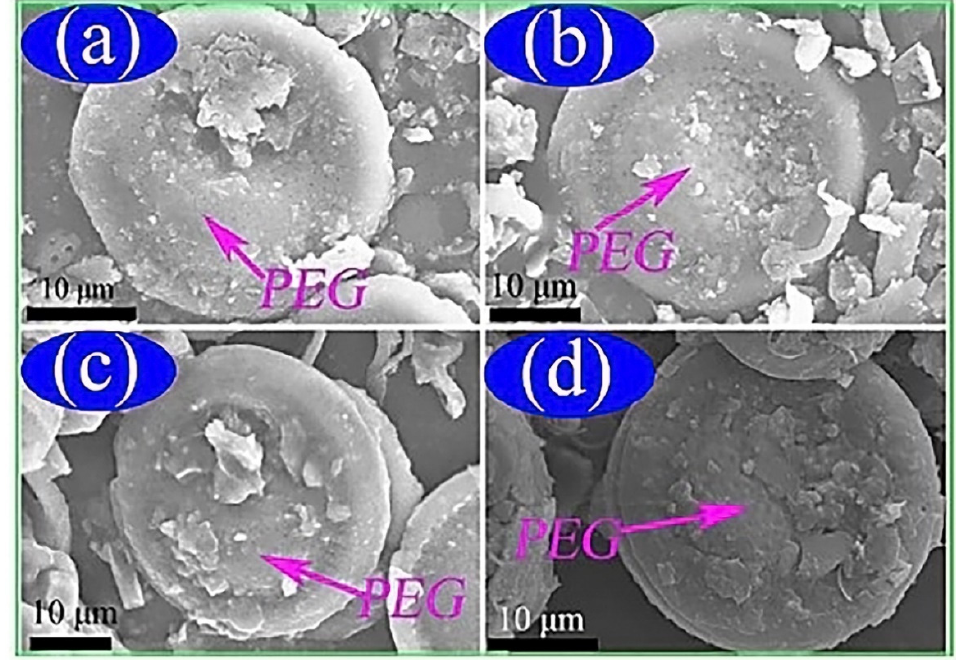
Figure 4. SEM analysis of prepared ( a ) 30%, ( b ) 40%, ( c ) 50%, ( d ) 63% PEG/DtAg ss-PCMs [41]. Thermal behavior of the samples was measured using DSC and the data obtained for the respective samples are presented in Table 2. Table 2. DSC results of different PEG/DtAg ss-PCM samples [41]